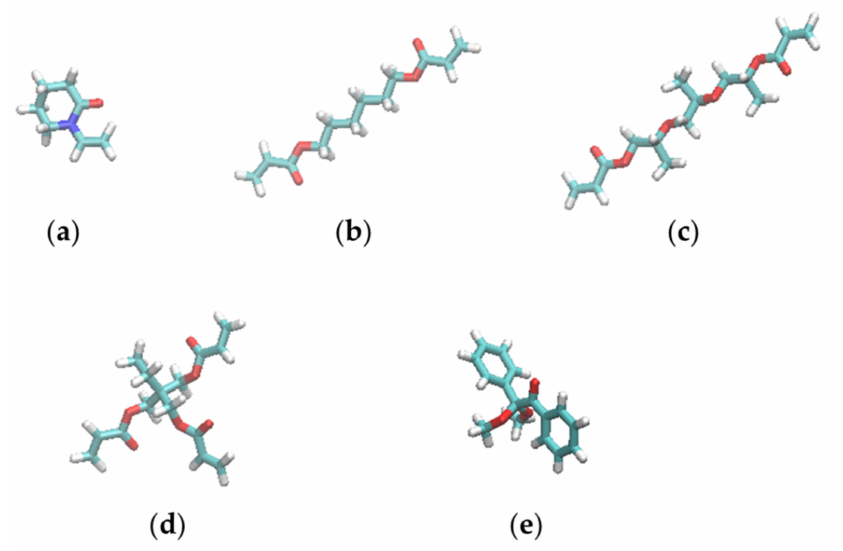
Figure 1. Structures of the molecules composing the resist materials used in this study: ( a ) NVP, ( b ) HDDA, ( c ) TPGDA, ( d ) TMPTA, and ( e ) DMPA. The figures were generated by visual molecular dynamics (VMD)